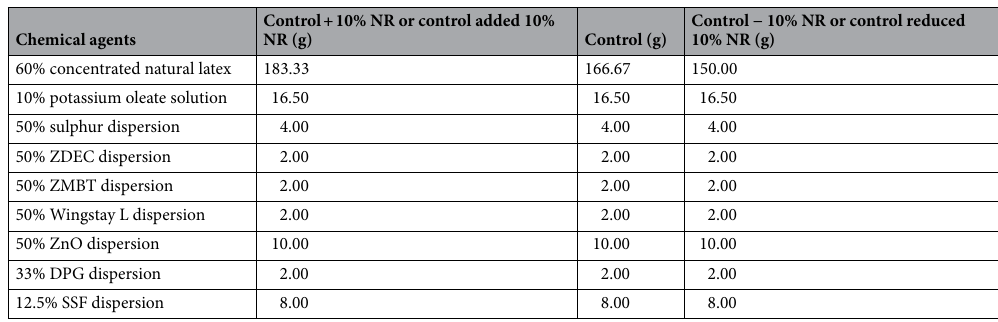
Table 1. Chemical agents used for the preparation of various foam